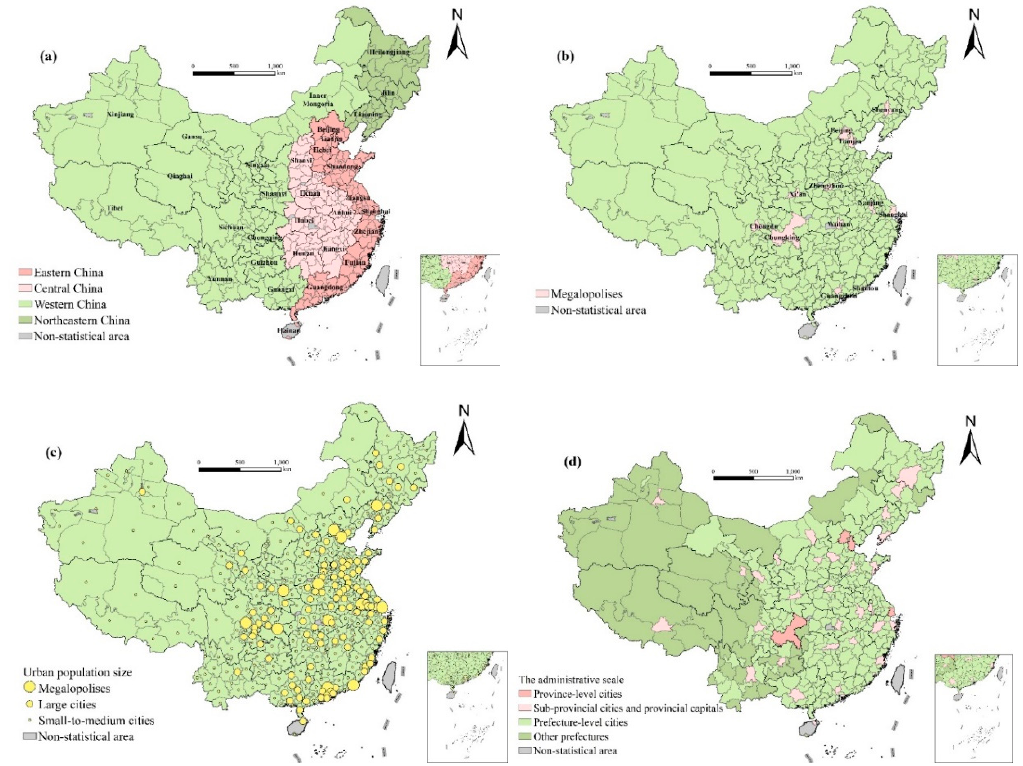
Figure 1. The study area: ( a ) the regional division; ( b ) megalopolises; ( c ) urban population size; ( d ) administrative